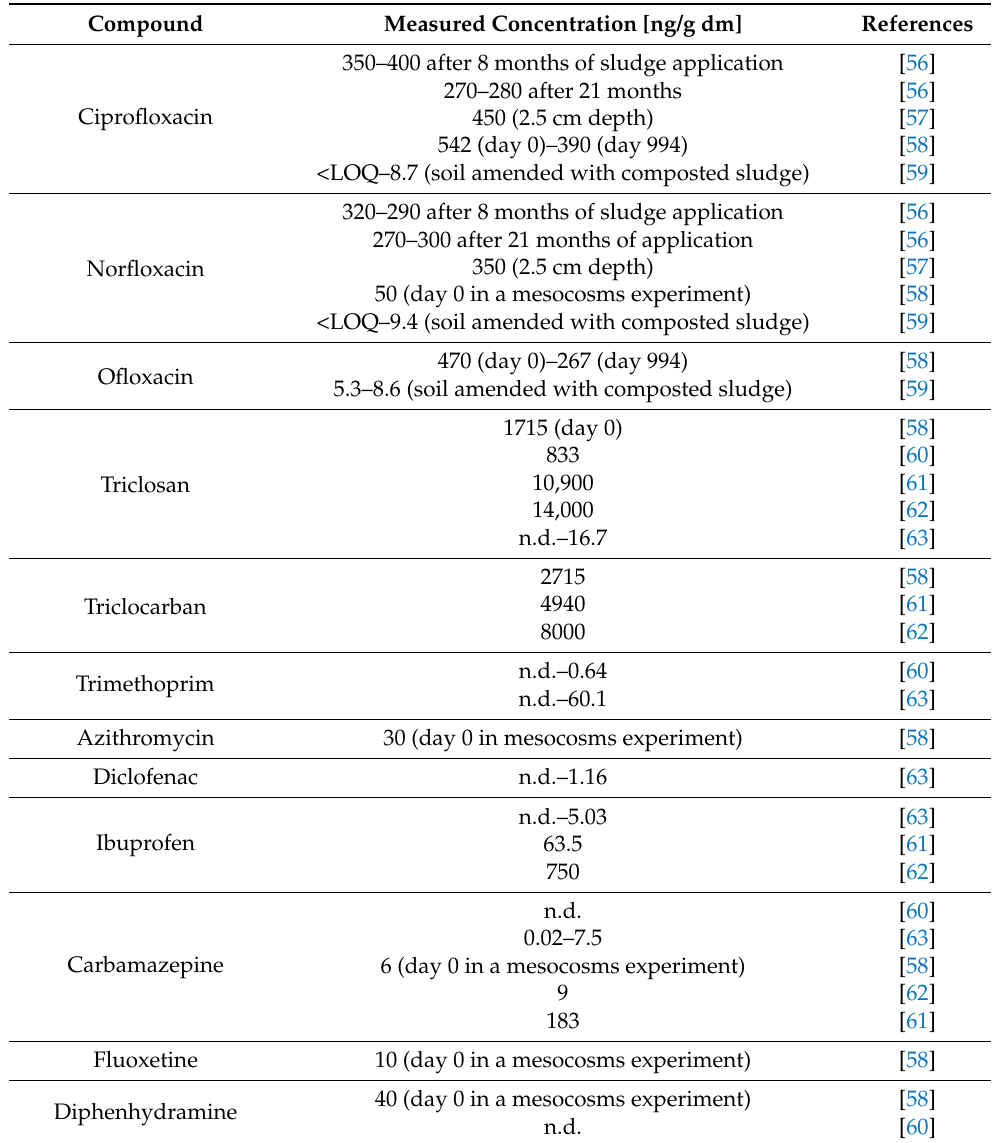
Table 2. Concentration of pharmaceuticals in soil treated with sewage